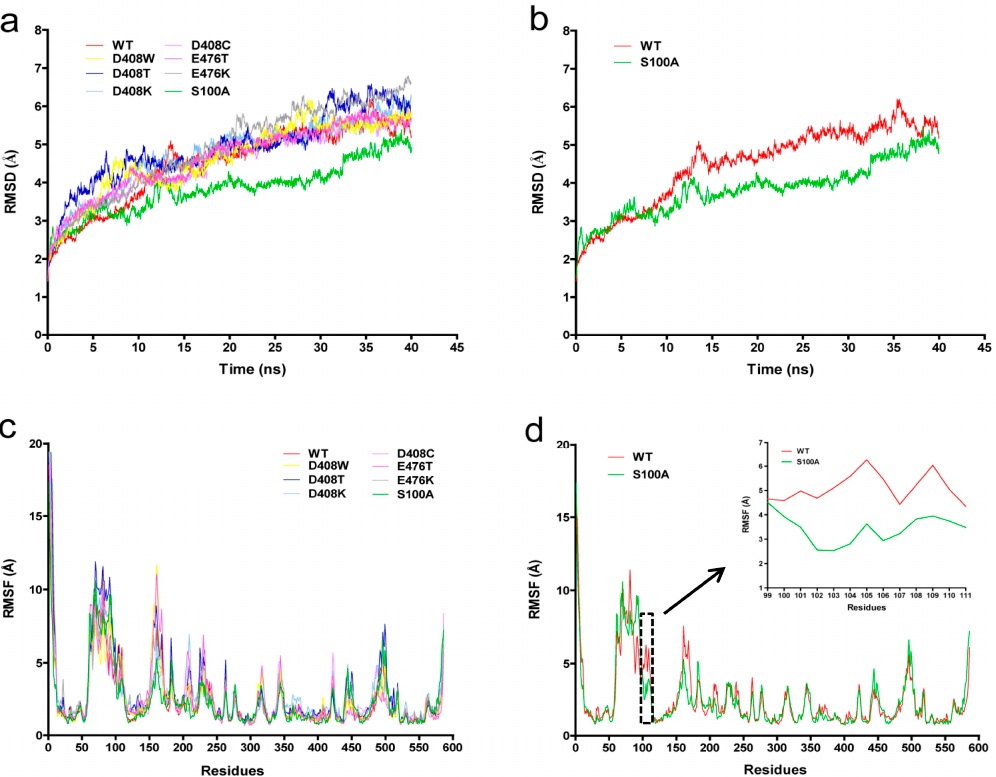
Figure 3. Molecular dynamics (MD) simulation of the protein structure of wild-type and mutant GOD m . ( a ) Root mean square deviation (RMSD) values during a 40-ns MD simulation for the wild-type (WT) and mutants at 400 K. The RMSD values of different proteins are shown as different colours; ( b ) RMSD values of S100A and WT; ( c ) Root mean square fluctuation (RMSF) values during a 40-ns MD simulation for wild-type and mutants at 400 K. The RMSF values of different proteins are shown as different colours; ( d ) RMSF values of S100A and WT. RMSF values curve of amino acids located at 99–111 position were boxed in black dotted line and enlarged.